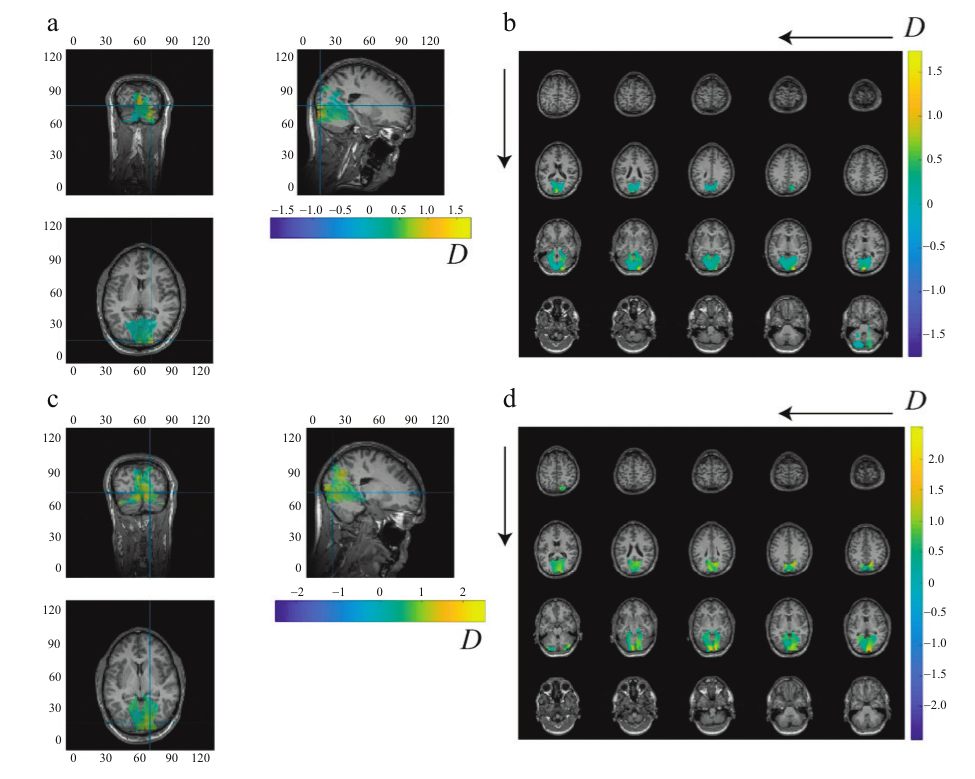
Figure 2. Distributions of normalized source power D within the visual cortex plotted superimposed on anatomical MRI in orthogonal cut view ( a , c ) and slice mode ( b , d ) for subject 2 ( a , b ) and subject 6 ( c , d ). The blue crosses in ( a , c ) define the cutting planes. The arrows in ( b , d ) indicate the direction of movement along the